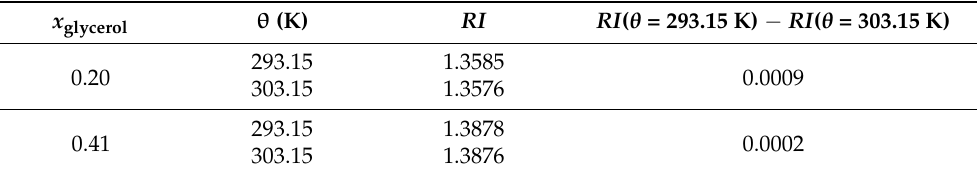
Table 4. Refractive index of two aqueous solutions of industrial glycerol, x glycerol = 0.20 and x glycerol = 0.41, at θ = 293.15 K and θ = 303.15